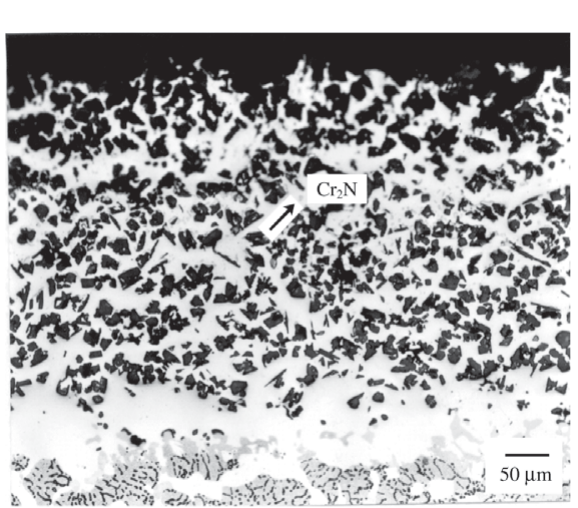
Figure 5. Cross-section of Alloy 1 after 260 cycles of